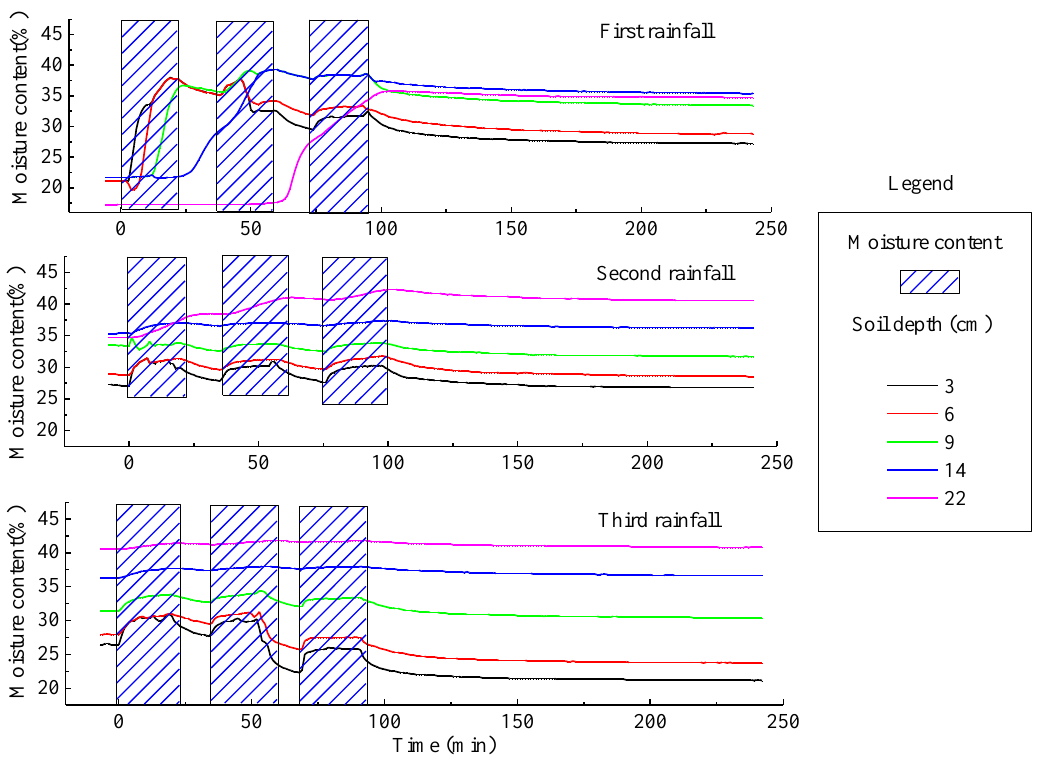
Figure 12. Dynamic change process of soil water content of the loess slope in 2.5 mm/min rain.